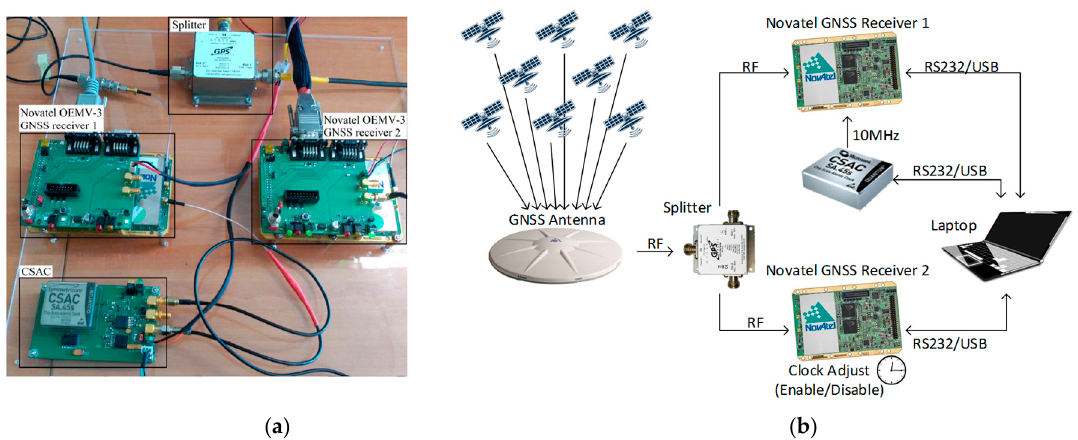
Figure 3. Basic CSAC configuration ( a ); and CSAC clock characterization example setup ( b ).